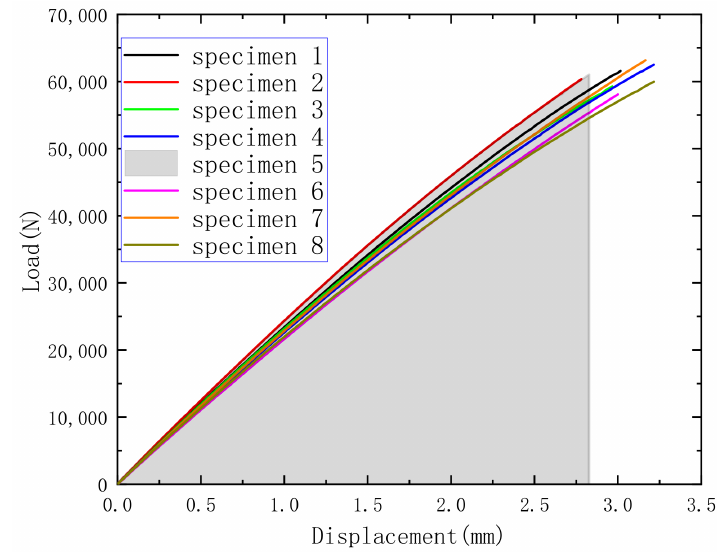
Figure 6. Load versus displacement for composite laminate specimens.